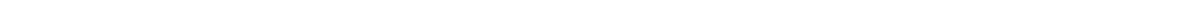
Fig. 1 Morgana is essential for TNBC cell invasion and in vivo metastasis formation. a Immunoblotting of Morgana and Vinculin, as loading control, in MCF7, MDA-MB-231, BT549 and MCF10A cell lines. b Immunoblotting of Morgana and Vinculin in MDA-MB-231 cells infected with empty vector (EMPTY) or two independent Morgana shRNAs (shMORG1, shMORG2). c Growth curves of MDA-MB-231. d Quanti fi cation of invasion assays performed on MDA-MB-231 EMPTY or shMORG1 and shMORG2. e Quanti fi cation of soft agar colony formation by MDA-MB-231 EMPTY or shMORG1 and shMORG2. f – h Representative haematoxylin and eosin stained sections f , quanti fi cation of g pulmonary metastases and h metastatic burden, 4 weeks after tail vein injection of MDA-MB-231 EMPTY or shMORG1 and shMORG2 ( n = 6 NSG mice per group). i Metastasis quanti fi cation in distant organs in mice injected with MDA-MB-231 EMPTY or shMORG1 and shMORG2 ( n = 3 NSG mice per group). j Tumor weight 5 weeks after subcutaneous injection of MDA-MB-231 EMPTY or shMORG1 and shMORG2 ( n = 6 NSG mice per group). k – m Representative haematoxylin and eosin stained sections k , quanti fi cation of l pulmonary metastases and m metastatic burden of MDA-MB-231 EMPTY or shMORG1 and shMORG2 ( n = 6 NSG mice per group). Data are the results of at least three independent experiments. Bars in graphs represent standard errors (* p < 0.05; ** p < 0.01; *** p <